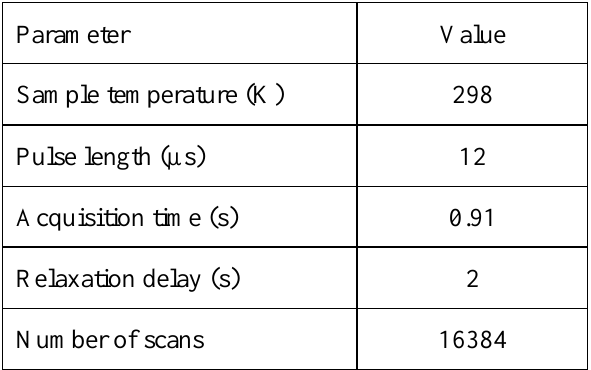
Table 1. Parameters of 13 C-NMR spectra